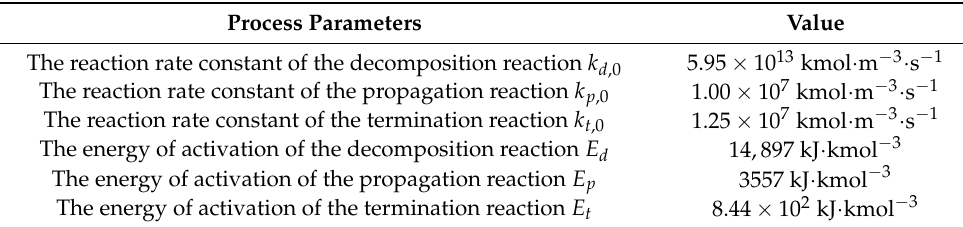
Table 2. Information of the reaction conditions in Case Study 2. Process Parameters Value The reaction rate constant of the decomposition reaction k d